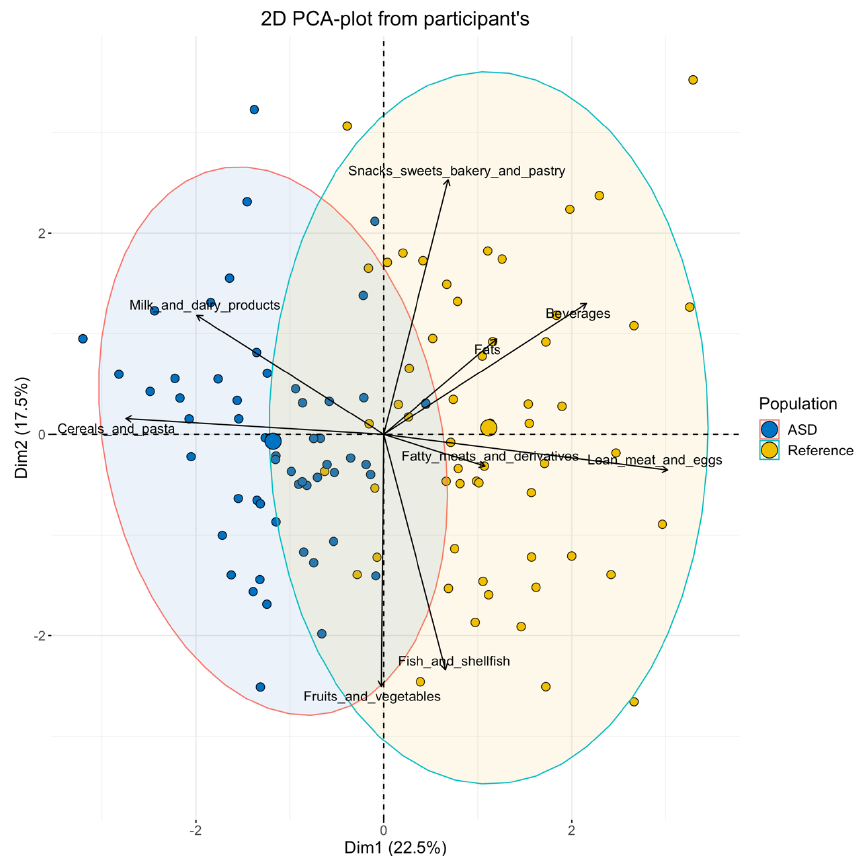
Figure 1. Principal component analysis (PCA) plot in the control and the children with autism spectrum disorders (ASD) according to the intake of major food groups determined by a standardized food frequency questionnaire.